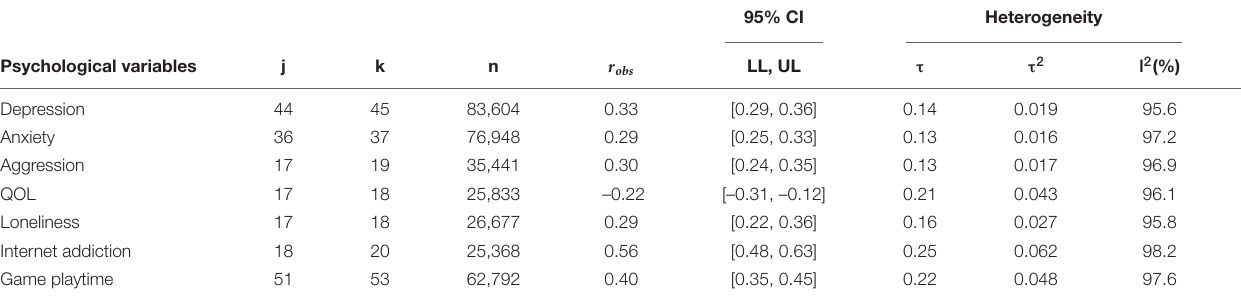
TABLE 3 | Association between GD and psychological/behavioral variables.